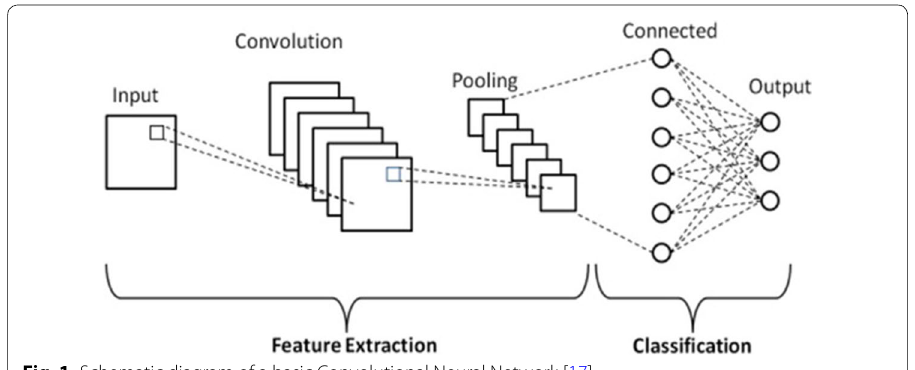
Fig. 1 Schematic diagram of a basic Convolutional Neural Network